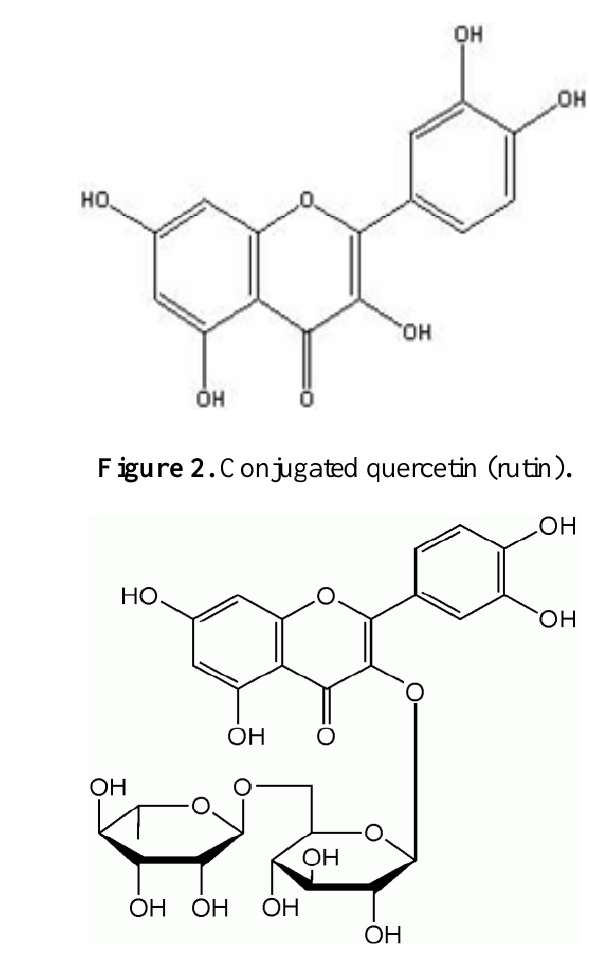
Figure 1. Quercetin aglycone.